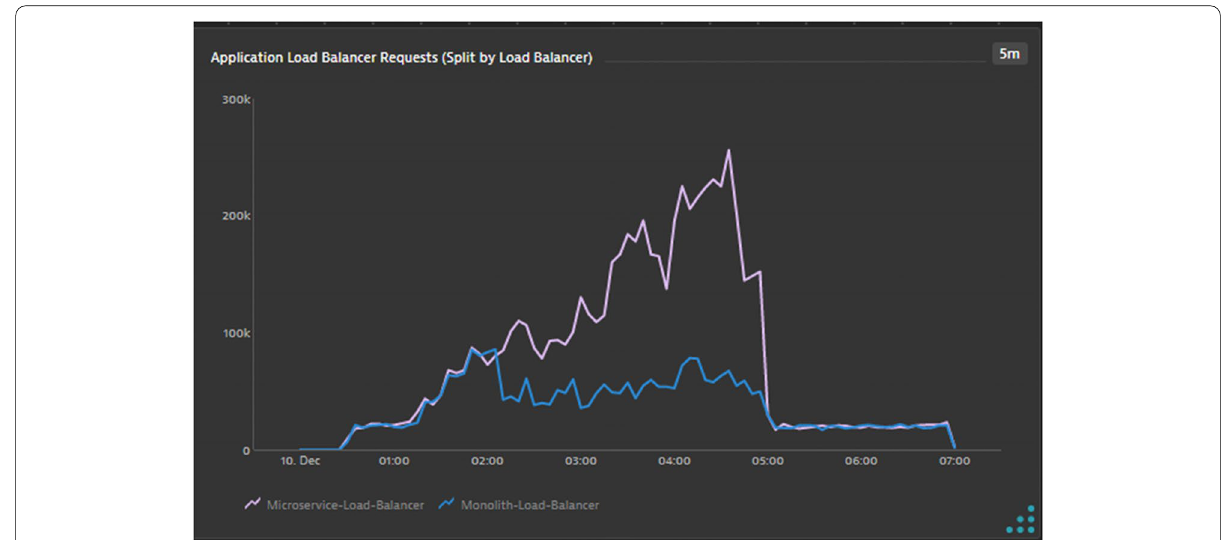
Fig. 8 Application load balancer requests (split by load